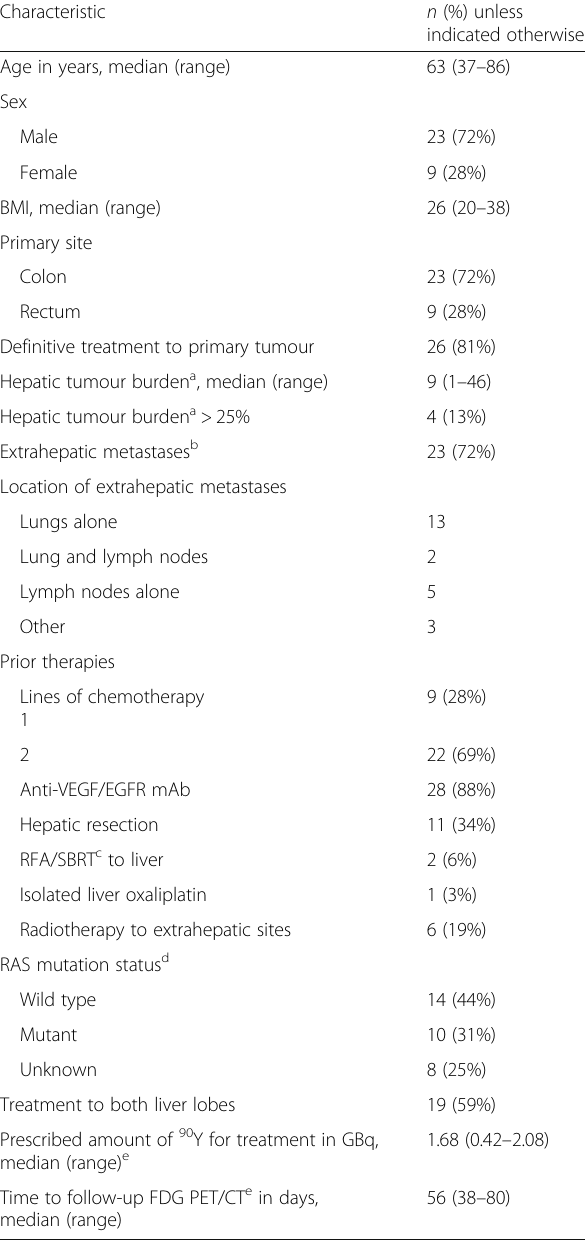
Table 1 Characteristics of study cohort at baseline ( n = 32)